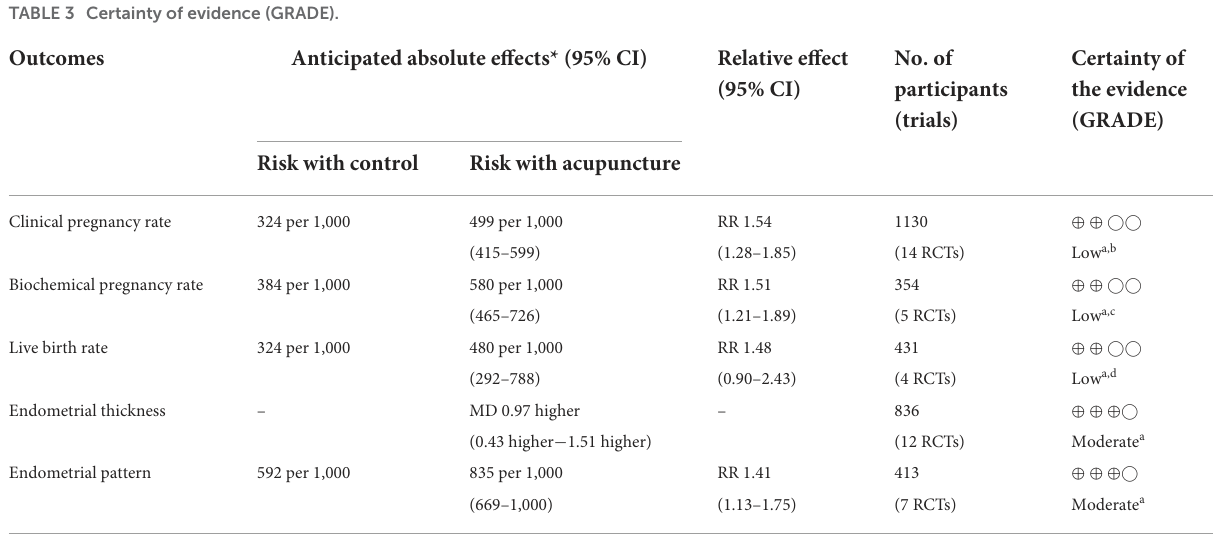
TABLE 3 Certainty of evidence